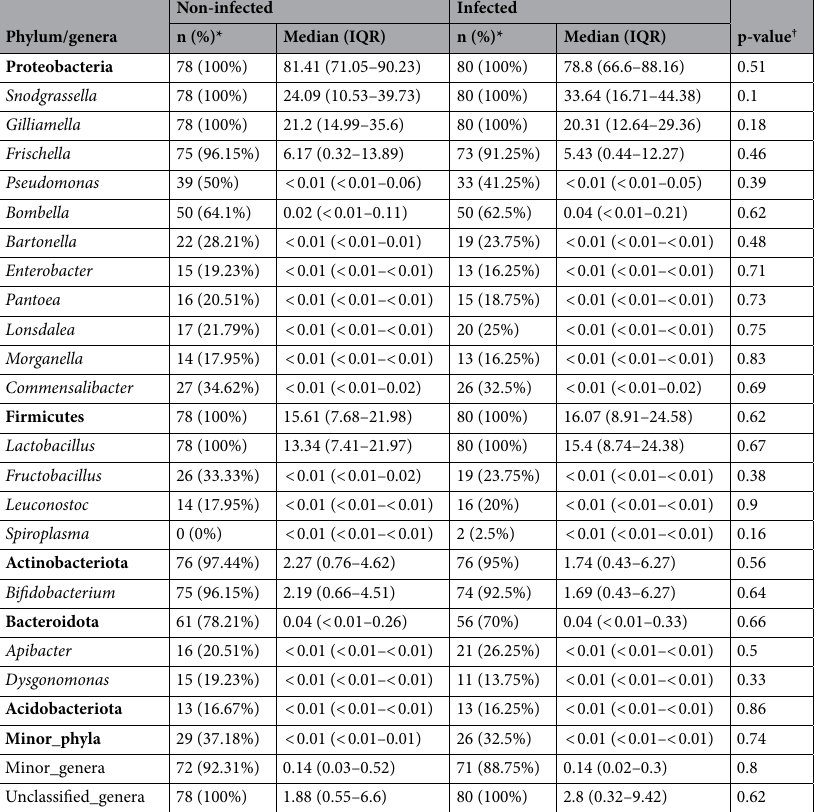
Table 2. Relative frequencies, medians and interquartile ranges (IQR) of the most abundant bacterial phyla (bold) and genera (italics) detected in AS of non-infected and infected bees. *Number of samples in which the phylum/genus was detected (relative frequency of detection). † Wilcoxon rank sum test with Bonferroni